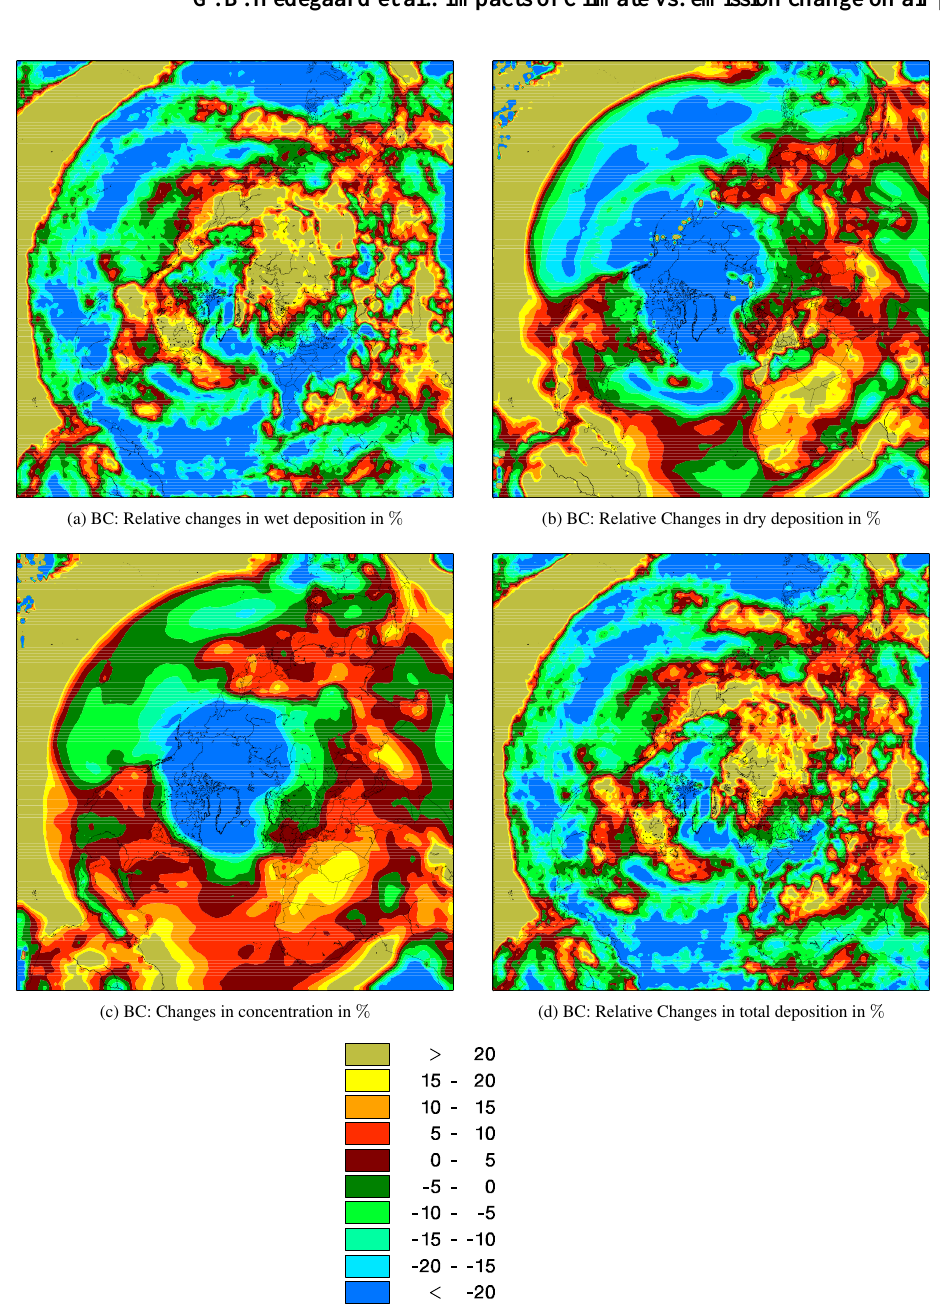
Fig. 6. Black carbon (BC): Relative change due to impacts of climate change in % (2090s and 1990s). (a) wet deposition, (b) dry deposition, Fig. 6: Black Carbon (BC): Relative change due to impacts of climate change in % (2090s - 1990s). a) wet deposition, b) dry deposition, (c) concentration, and (d) total c) concentration, and d) total deposition.